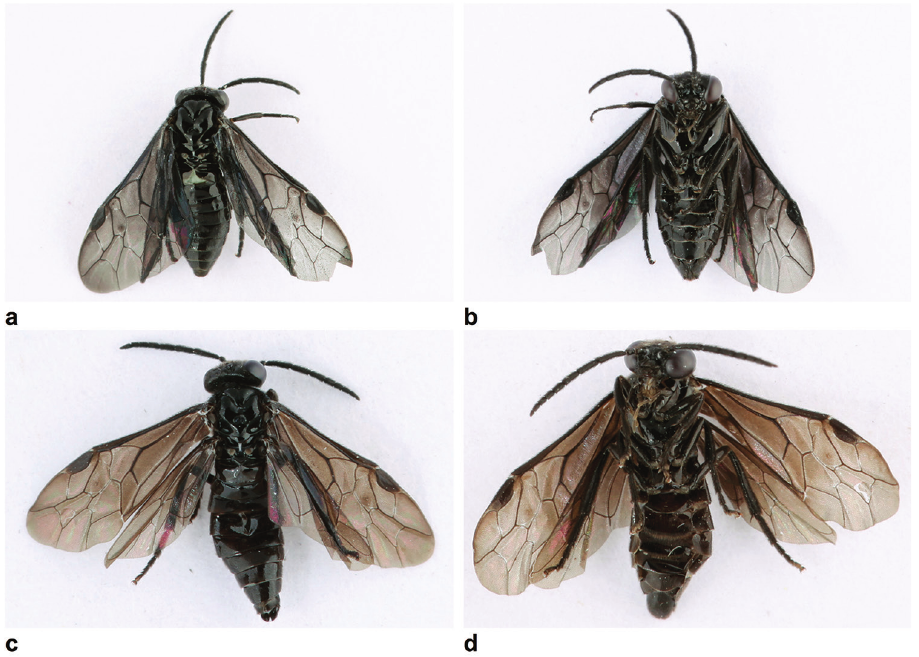
Figure 18. Inea sp. a, b Female (P4241.A), body length 6.5 mm c, d male (P4230.B), body length 6.5 mm. a, c Dorsal views b, d ventral views.